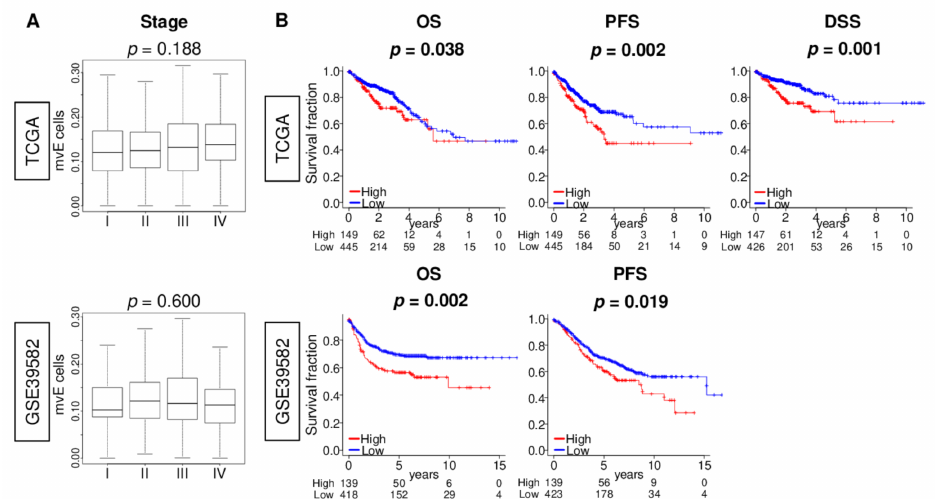
Figure 5. Association between amount of the mvE cells with clinical aggressiveness in the TCGA and GSE39582 cohorts. ( A ) Box plots of the mvE cells by the American Joint Committee on Cancer (AJCC) stage in both cohorts. p -value was calculated by Kruskal–Wallis test. ( B ) Kaplan–Meier curve plots of overall survival (OS) and progression-free survival (PFS) in both cohorts, and disease-specific survival (DSS) in the TCGA cohort by high (red) and low (blue) mvE cells groups with the p -value. p -value was calculated by the log-rank test. The top one-fourth was used as a cut-off to divide low and high groups for each